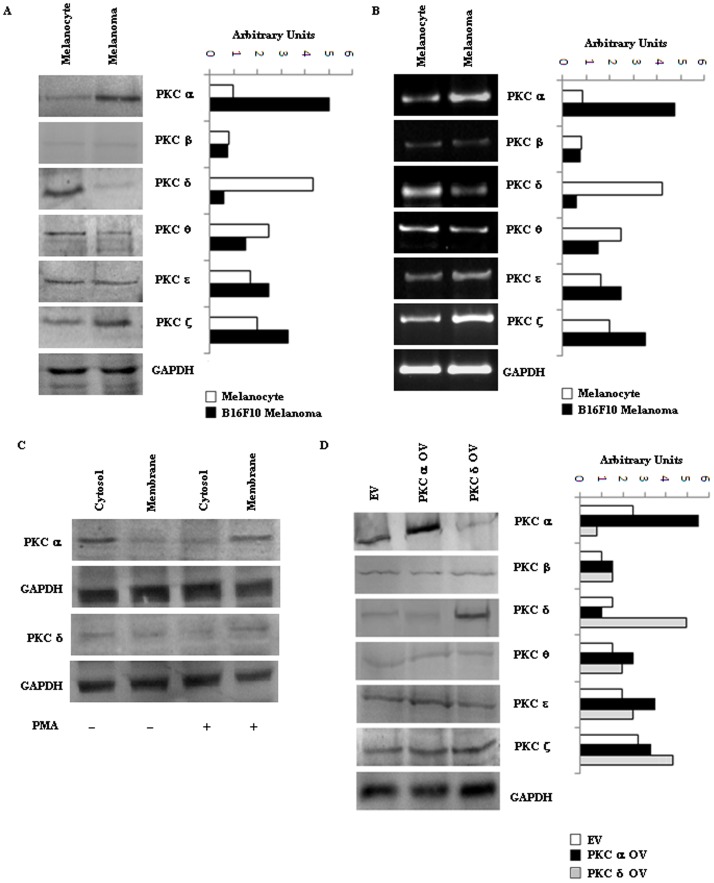
Differential expression of various PKC isotypes in B16F10 melanoma tumor.(A) Cell lysates from primary melanocytes and B16F10 melanoma cells were subjected to western blot analysis with anti PKCα, PKCβ, PKCδ, PKCθ, PKCε and PKCζ specific antibodies. GAPDH was used as a reference. Representative figure and bar diagram of densitometric analysis from three independent experiments are presented. (B) 2×106 primary melanocytes and B16F10 melanoma cells were separately collected in Trizol for mRNA extraction and semi quantitative RT-PCR analyses for PKCα, PKCβ, PKCδ, PKCθ, PKCε and PKCζ were done. Representative figure and bar diagram of densitometric analysis of target gene with respect to GAPDH was presented. (C) 2×106 B16F10 melanoma cells were treated with PMA (100 nM) for 1 hr. Expression of PKCα and PKCδ along with GAPDH in cytosolic and membrane protein fraction was analyzed by Western blot. Representative data from three independent experiments was given. (D) Cell lysates of B16F10 cells transfected with empty vector (EV), overexpressed full-length mouse PKCα (PKCαOV) or PKCδ (PKCδOV) isotypes as mentioned in materials and methods were subjected to SDS PAGE and western blot analysis to check the respective expression of PKCα, PKCβ, PKCδ, PKCε, PKCθ and PKCζ isotypes. Representative figure from three independent experiments and bar diagram of densitometric analysis was depicted. GAPDH was used as a reference.